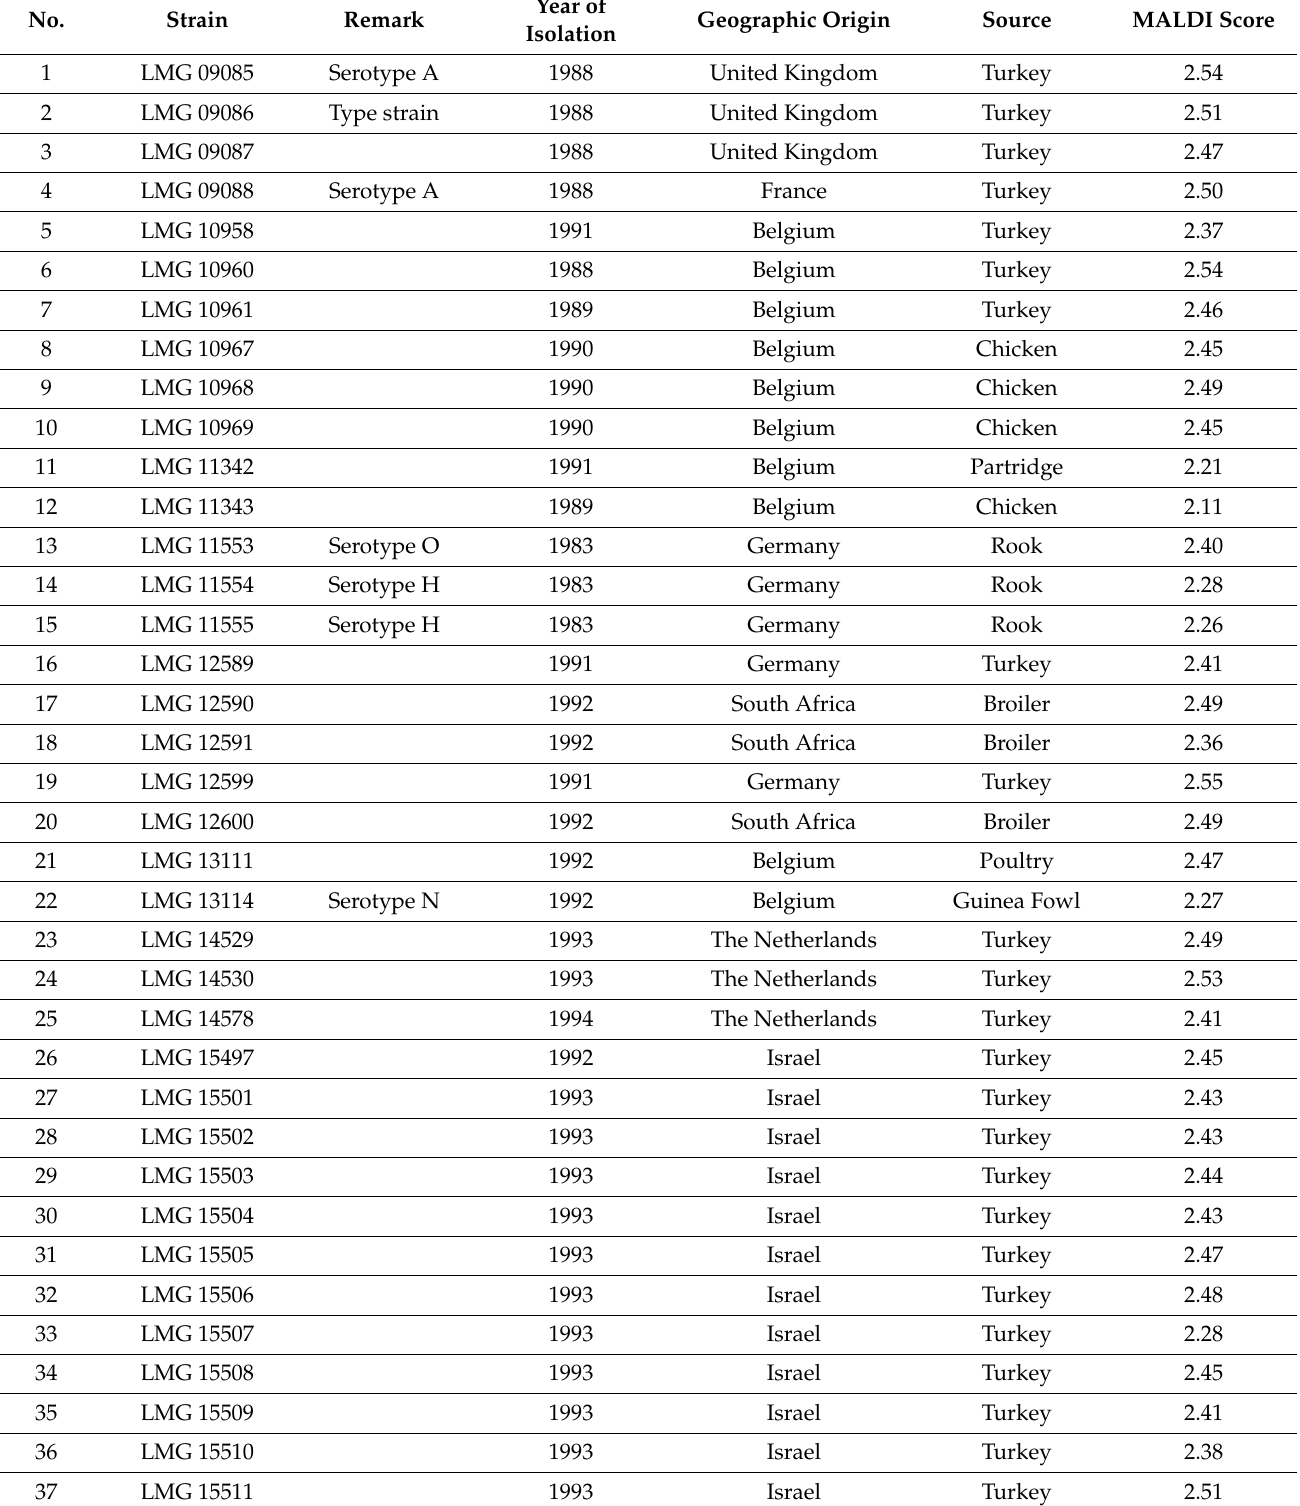
Table 1. Established MALDI-TOF MS Reference